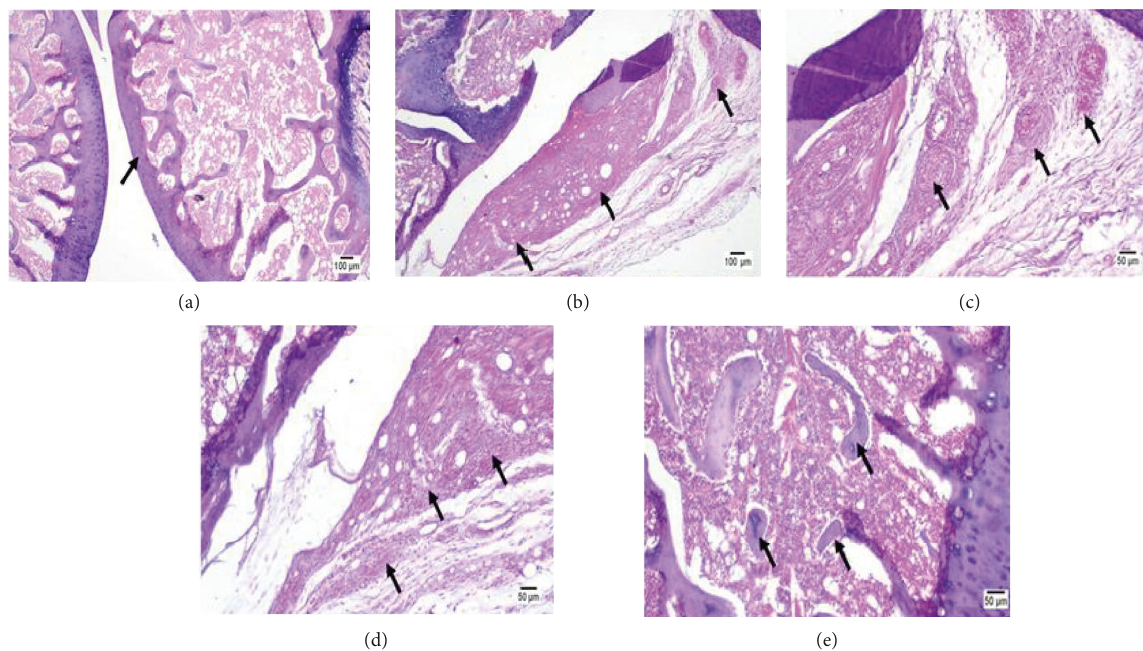
Figure 6: (a) Positive control group, showing mild thinning in the cartilage coating the head of the bone (arrow); (b) showing inflamed joint capsule and synovium (arrows); (c) higher magnification showing perivascular inflammatory cells infiltration (arrows) and edema in the synovial membrane; (d) higher magnification showing inflammatory cells infiltration (arrows) and edema in the synovial membrane; and (e) showing mild thinning in the trabecular bone (arrows) of the